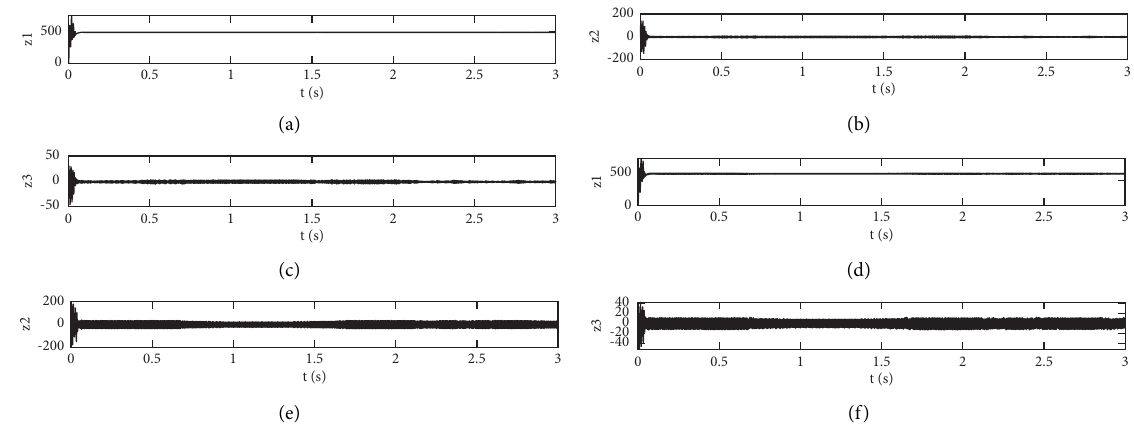
Figure 6: Response curves of adaptive ESO and ordinary ESO.